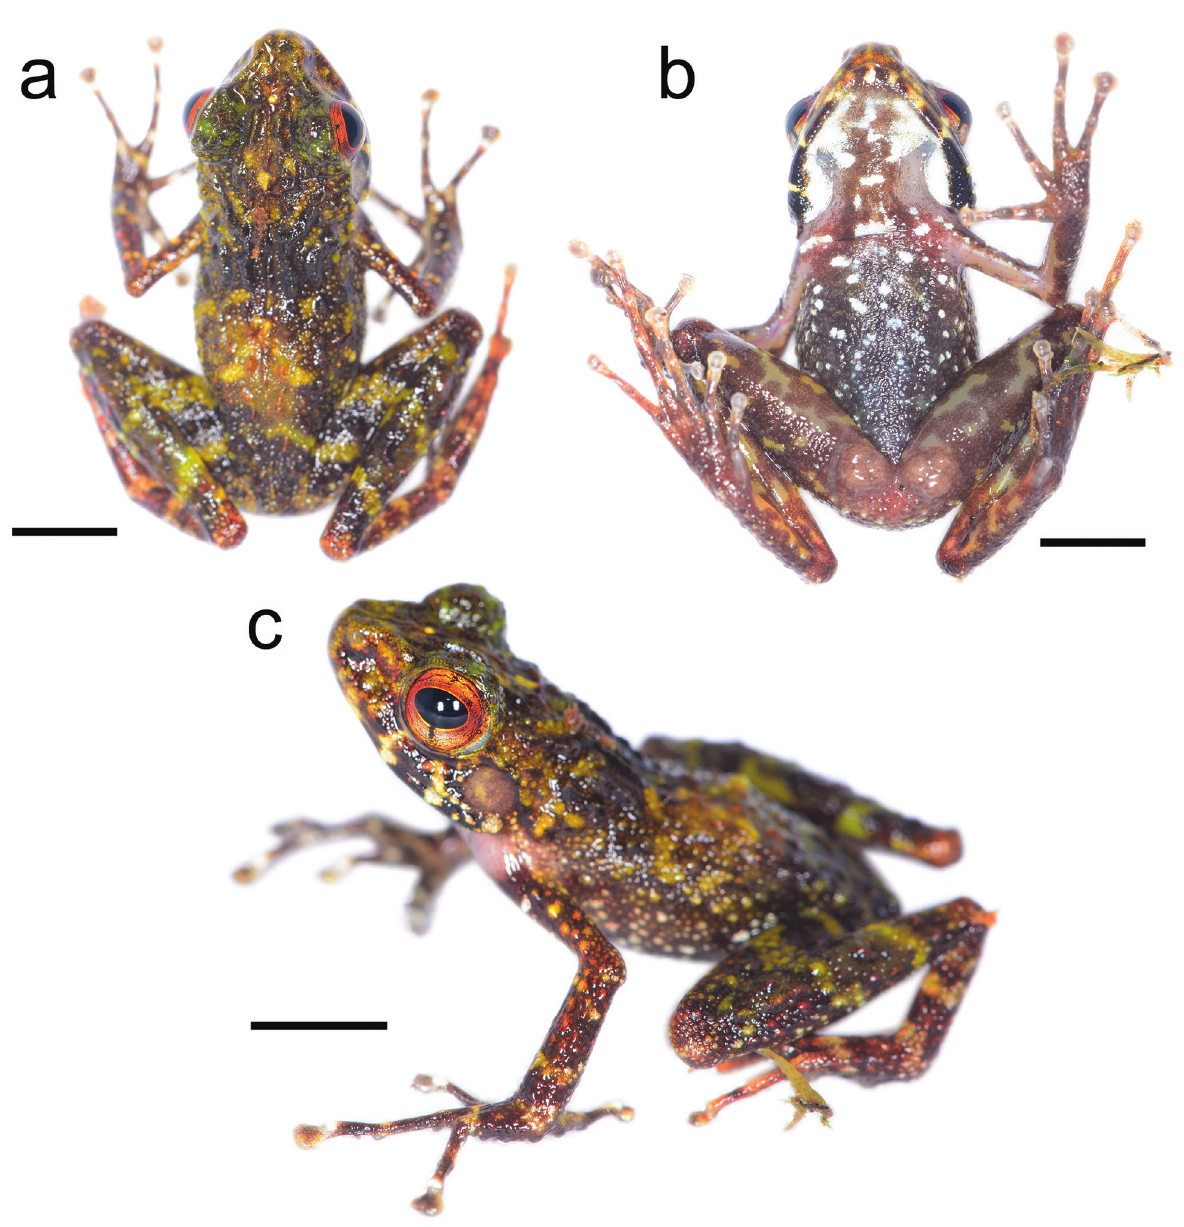
Figure 2. The holotype of Gephyromantis lomorina sp. n., ZSM 419/2016 (ZCMV 15221) in life. (a) Dorsal; (b) ventral; and (c) dorsolateral view. Scale bars indicate 5